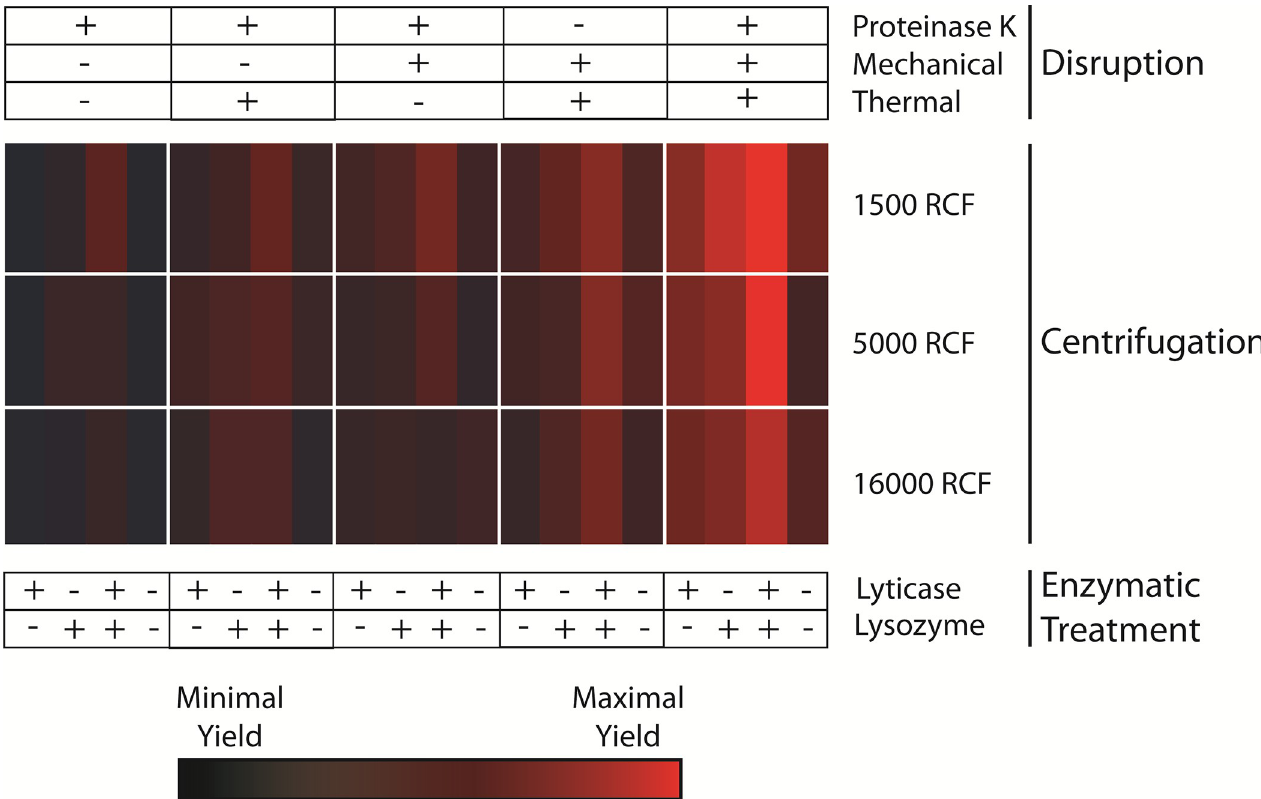
Fig 2. Large-scale confirmation of optimization of microbial DNA purification. The individual conditions noted to increase yields were tested in aggregate in a larger-scale optimization panel. DNA was concurrently isolated from 60 identical 1 ml urine samples from each of 4 subjects with variations in cell wall disruption methods (as indicated at the top), enzymatic pre-treatment methods (bottom), and centrifugation speeds (rows indicated at right adjacent to heat map). Fungal DNA yields from these 60 variations in isolation methodology were calculated from Fungiquant qPCR as described in Fig 1, then scaled across all samples. Values are expressed as a heat map, with bright red signifying the highest yields and black the lowest yields across all samples.